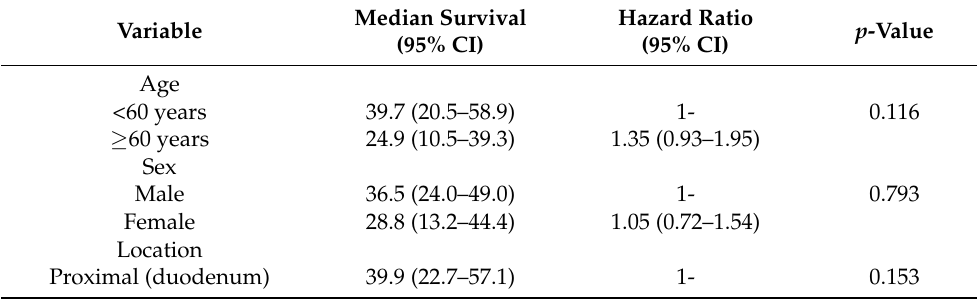
Table 5. Univariate analysis of prognostic variables affecting patient survival with